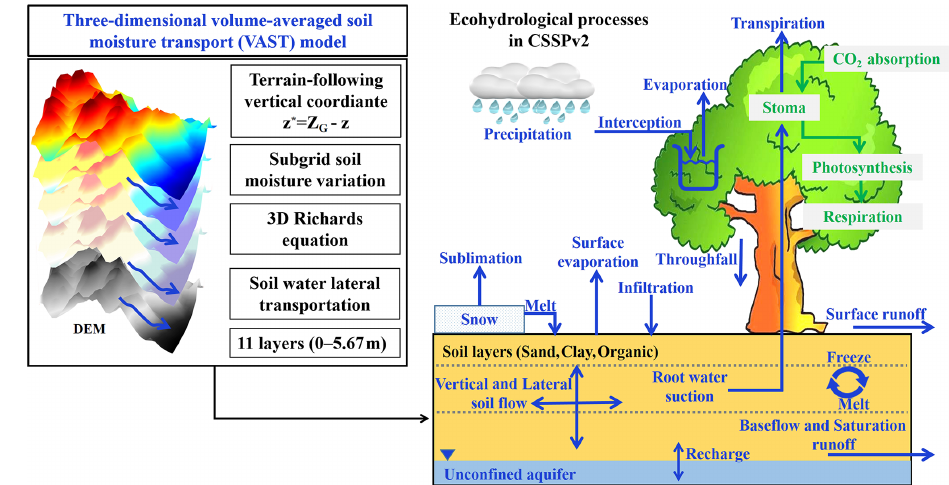
Figure 2. Main ecohydrological processes in the Conjunctive Surface-Subsurface Process version 2 (CSSPv2) land surface model.